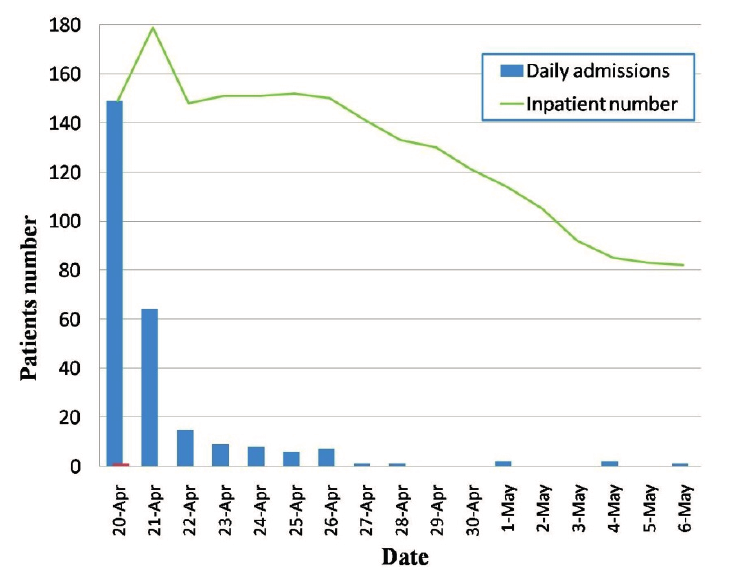
Figure 2. Distribution of the patients admitted to the three military hospitals on the basis of their date of admission and